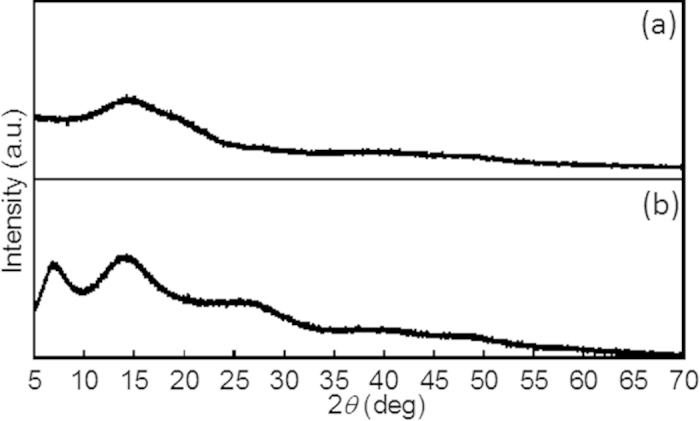
Synchrotron XRPD patterns obtained froma) SiO2 and b) SiO2/Eu nanoparticles (λ = 0.99933 Å).